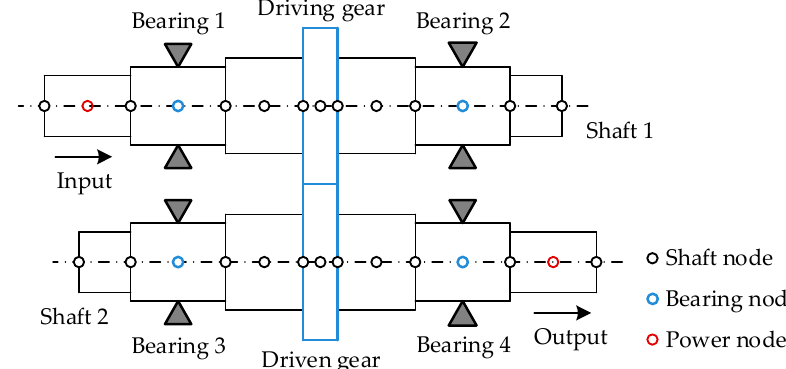
Figure 5. Schematic diagram of HGRS. Table 1. Parameters of helical gear pair.